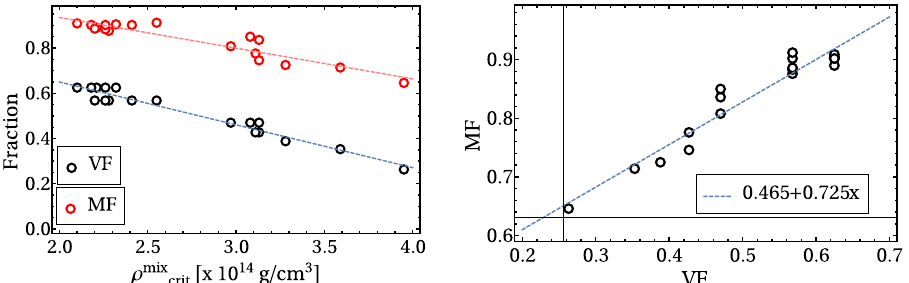
Fig. 4 (Left panel) The plot shows relation between the volume frac- quark matter in the interior of the star showing linear relation among tion and mass fraction with the critical density ρ mix of appearance of them.Thecalculationhasbeendonefor1 . 4 M (cid:8) hybridstarsconstructed crit quark matter and shows a decreasing pattern with increase in density. (Right panel) Volume fraction has been plotted with mass fraction of